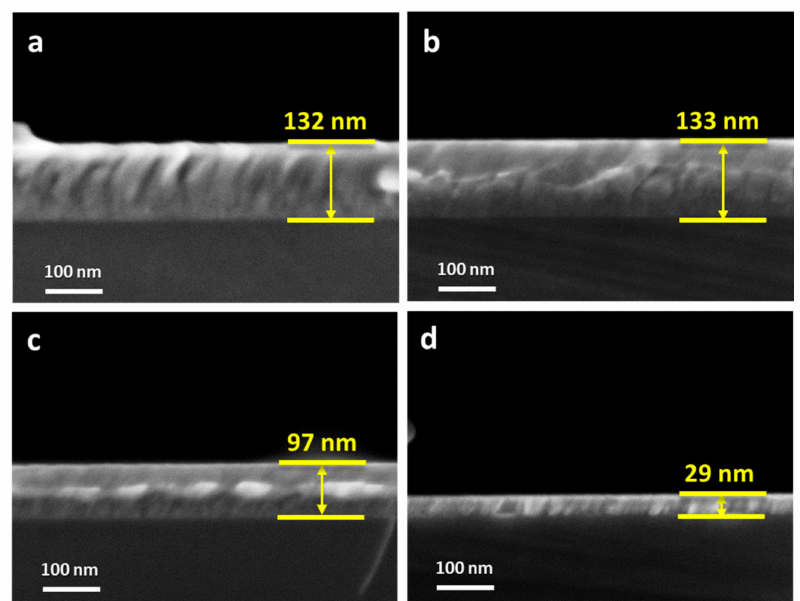
Figure 4. SEM images of the Ti films deposited on Si substrates under 80 mTorr at biases of ( a ) − 30 V ( b ) − 10 V ( c ) 0 V, and ( d ) +50 V.